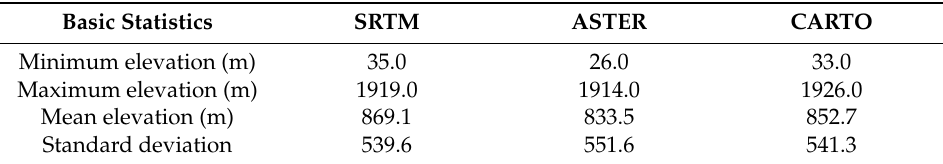
Table 1. Characteristics of depressionless DEMs.